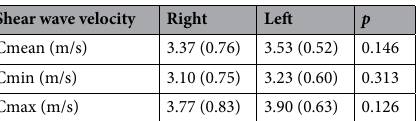
Table 2. Comparison of bilateral median nerve shear wave velocity in the same volunteer.